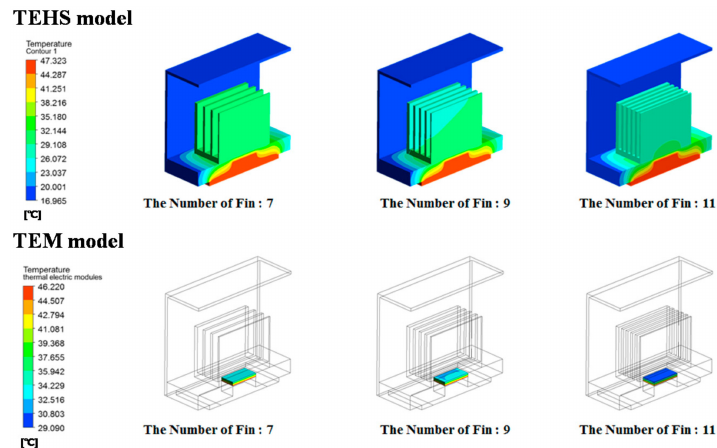
Figure 4. Numerical analysis results of temperature gradient of the TEHS with varying number of cooling